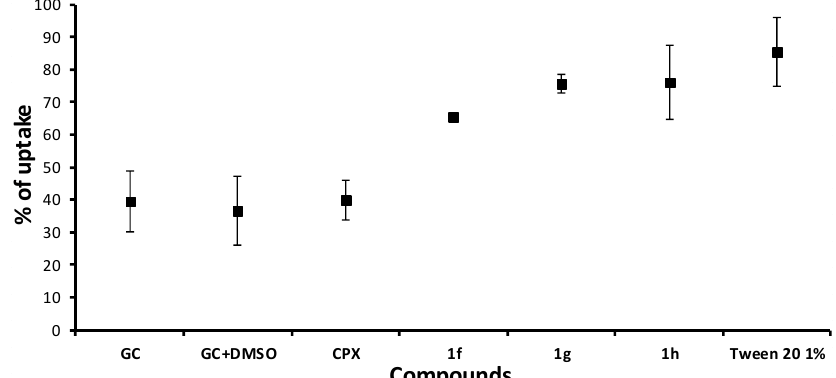
Figure 3. Crystal violet uptake of 1f , 1g , and 1h (64 µg/mL) treated with S. aureus ATCC 29213. Means ± SD for three replicates are illustrated. GC = growth control; GC + DMSO = growth control with DMSO equal to the concentration of DMSO in tested tubes; CPX = ciprofloxacin. CPX, as an agent non-interacting with the cytoplasmic membrane, was used as a negative control, while 1% solution of surface active Tween 20 was used as a positive control. The e ff ect of CPX on violet uptake was comparable to the uptake of non-treated cells (p < 0.05). All of the tested